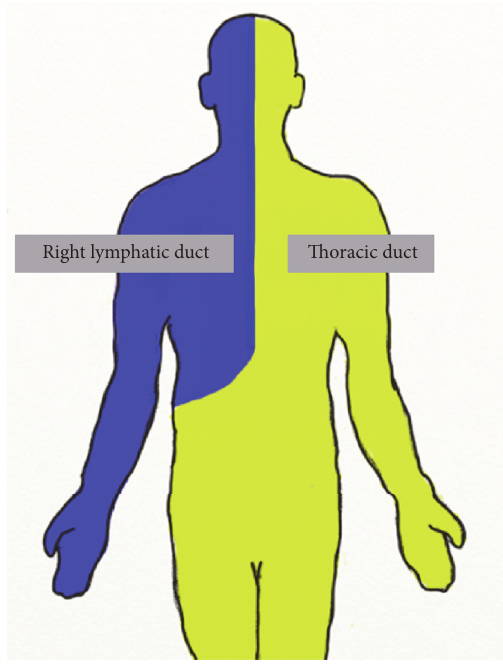
Figure 1: Lymphatic division. The right lymphatic duct collects lymph from the right side of the body, above the diaphragm. The thoracic duct receives lymph from the entire left side of the body and the right side of the body below the diaphragm.